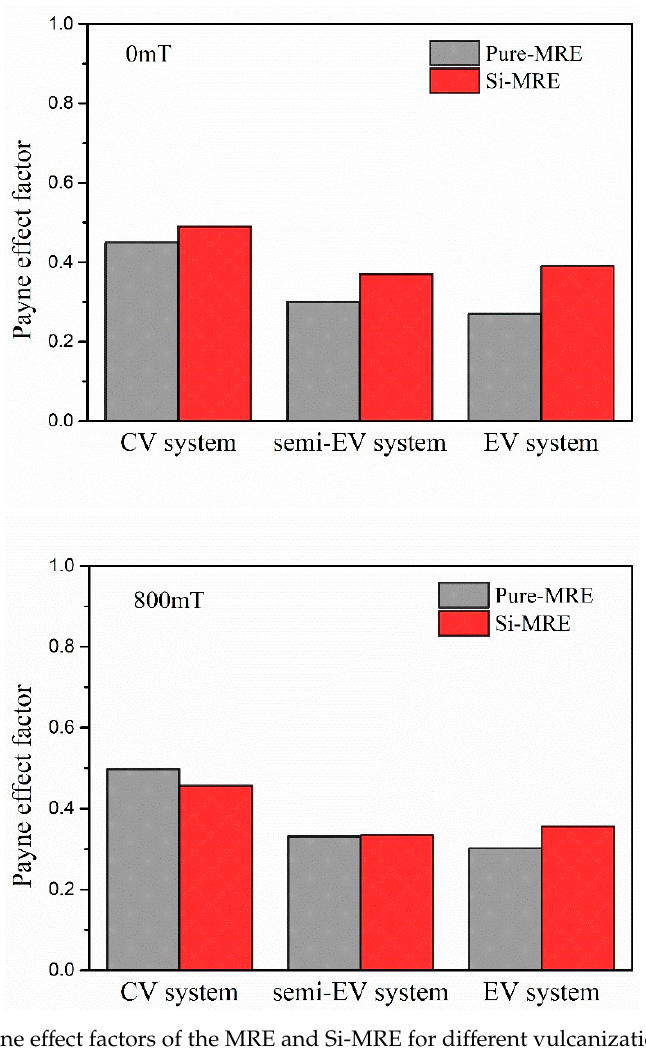
Figure 7. The Payne effect factors of the MRE and Si-MRE for different vulcanization systems under different magnetic field strengths.